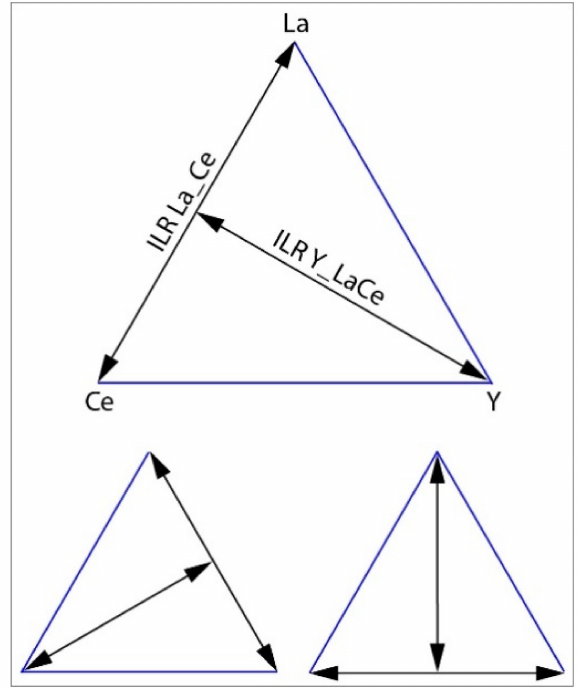
Figure 4. A ternary plot can be used as a guide for selecting log ratios where the (sub-)composition involves three elements. This plot shows different methods for selecting two independent